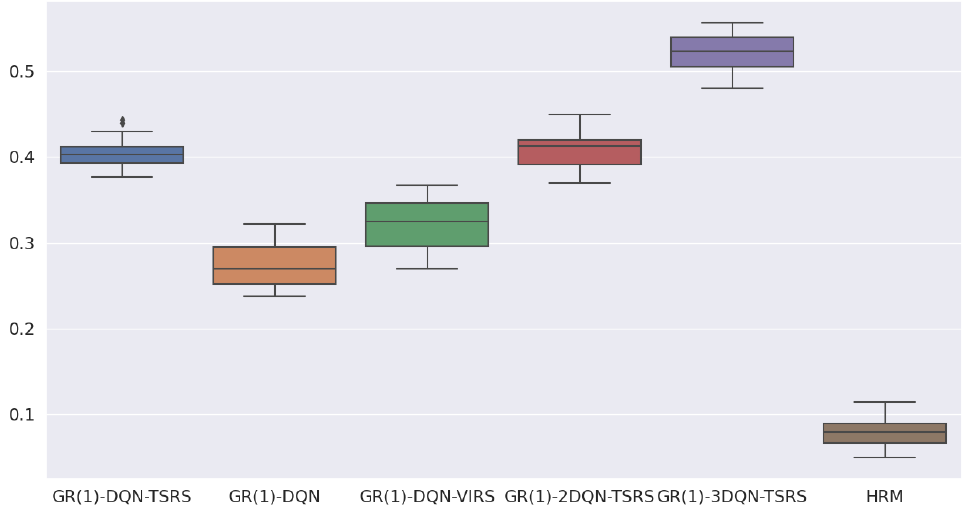
Figure 16. Box plot of learning curve for ϕ 2 under the environment setting